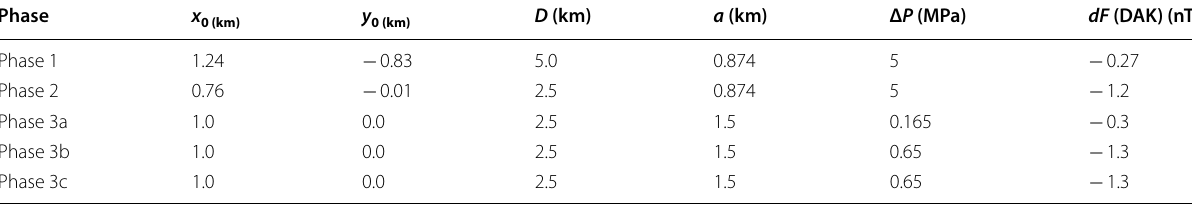
( x 0 , y 0 ) is the horizontal location of the center of the Mogi source, D its depth, a its radius and ∆ P the internal hydrostatic pressure, respectively. dF are the computed values. The origin of the horizontal coordinates is taken at (14.01°N, 121.00°E), which is located around the center of the MCL